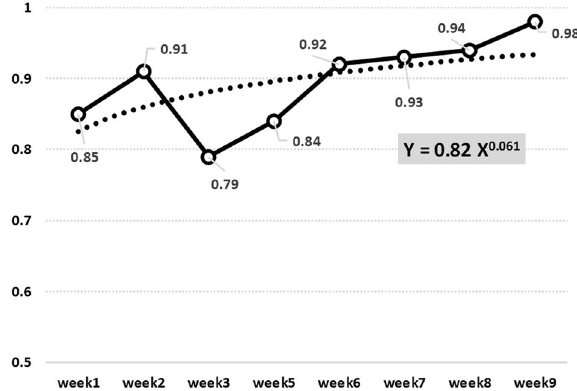
Fig. 6 Entropy evolution. Normed entropy based on the cluster membership probability value for each word as a function of